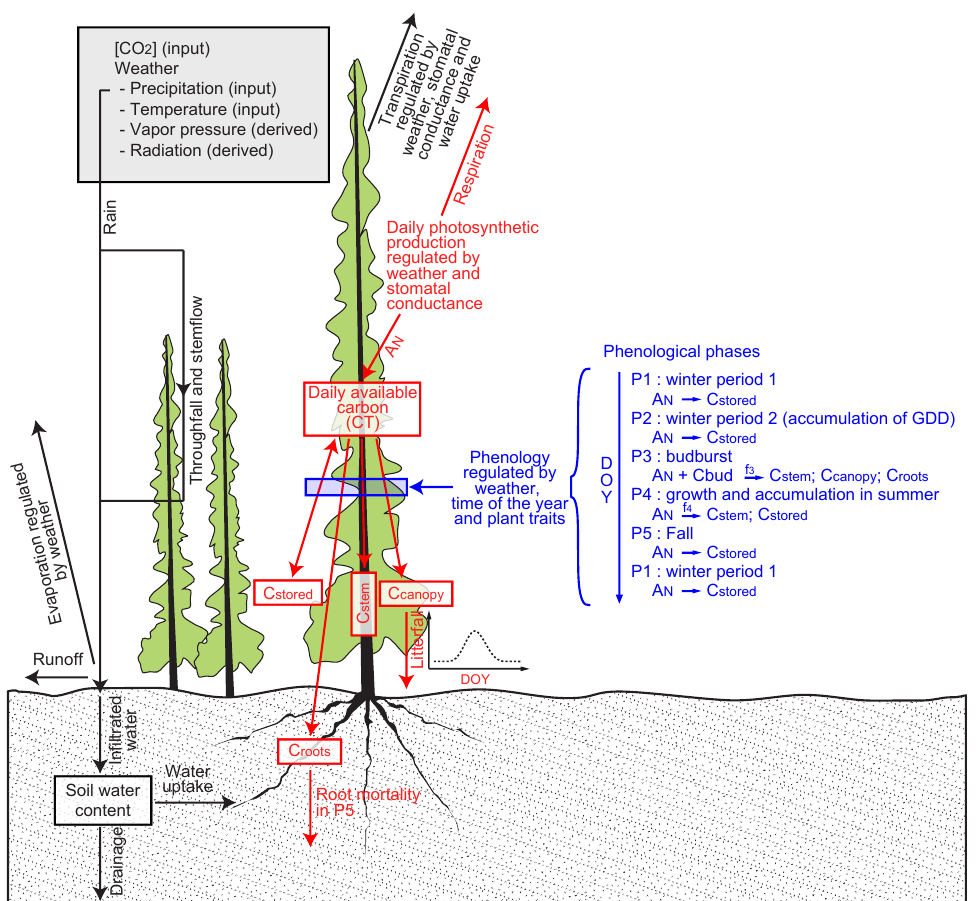
Figure 1. MAIDEN-simulated phenology (blue), water (black) and carbon (red) fluxes. AN: net photosynthesis corresponding to net primary production. Cstored, Cstem, Ccanopy and Croots: carbon allocated daily to stored non-structural carbohydrates, stem, canopy and roots, respectively. DOY: day of the year (1–365). GDD: growing degree days. f 3 and f 4 : functions determining carbon allocation in phases 3 and 4. Cbud: amount of storage carbon that is used each day by the plant in phase